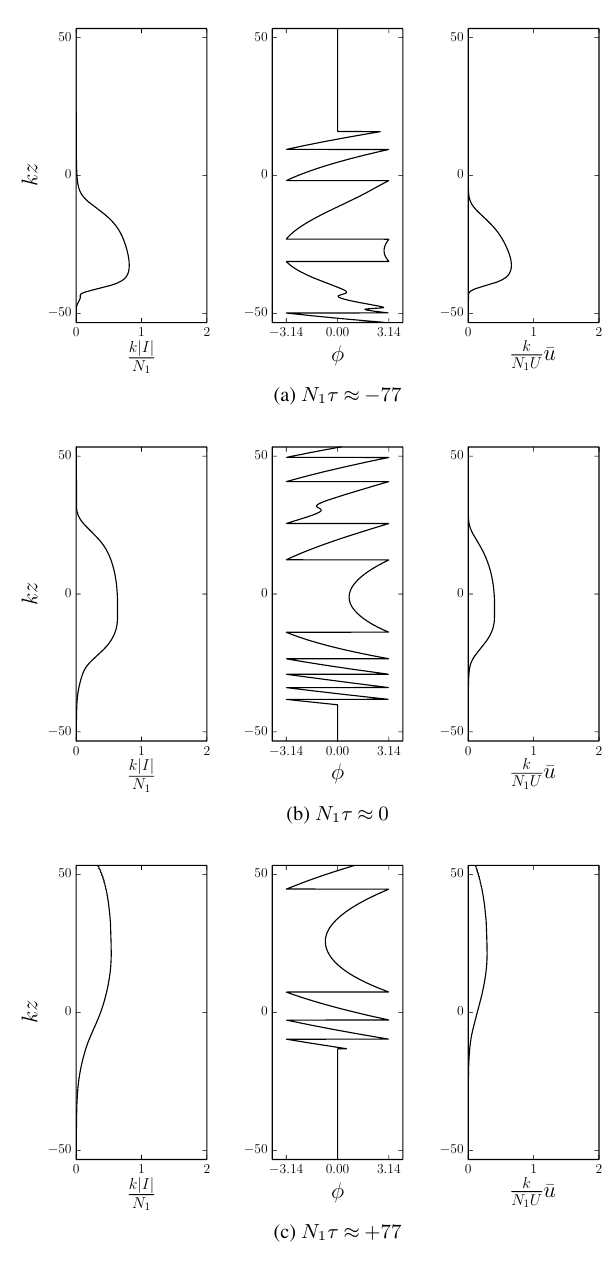
Figure 10. Vertical profiles of the wave magnitude (left panel), phase (center panel), and mean flow (right panel) at three times in a single layer of constant N with n 1 /k = 1, (cid:15) = 0.025, and α =